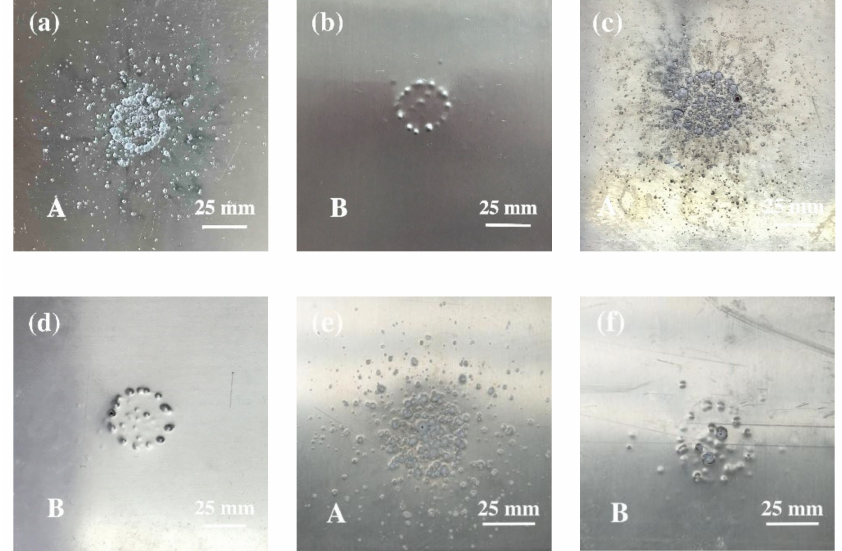
Figure 3. Macro-morphologies of the rear wall with di ff erent bumpers. ( a , b ) bumper I; ( c , d ) bumper II; ( e , f ) aluminum alloy bumper.